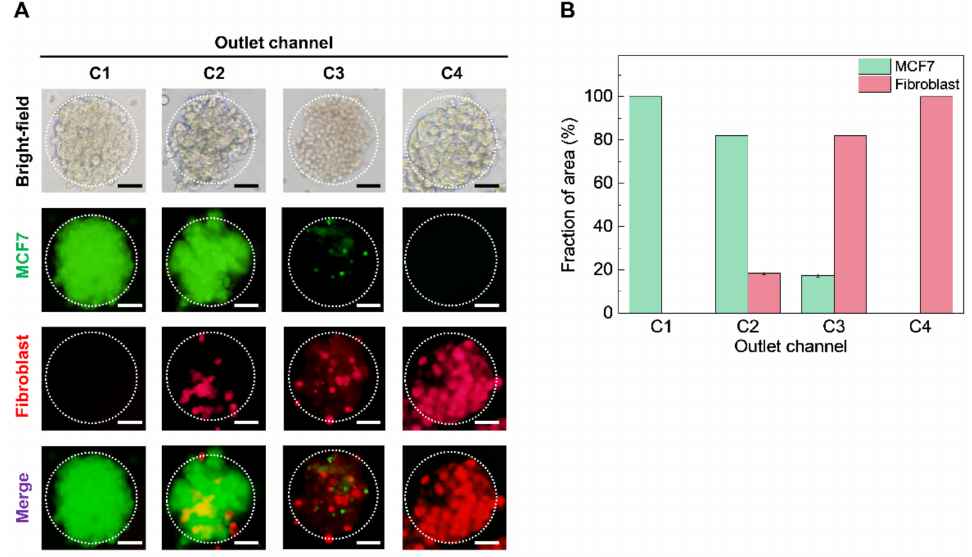
Figure 3. Multicellular spheroids within a droplet formed by the microfluidic gradient device. ( A ) Encapsulated cell images (MCF-7 and fibroblast cells were stained by CellTrace™ CFSE and CellTrace™ Far Red, respectively). Scale bars are 100 µ m. ( B ) Graph of relative percentage of cells in encapsulated droplet by each